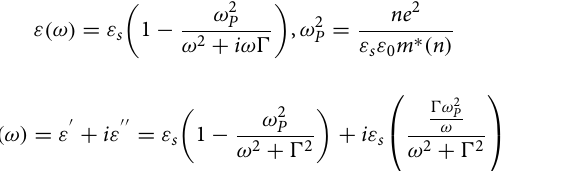
Figure 2. Material dispersion of highly doped silicon with a concentration of 5 × 10 20 cm higher than 3 μm, the real part of the dielectric function becomes